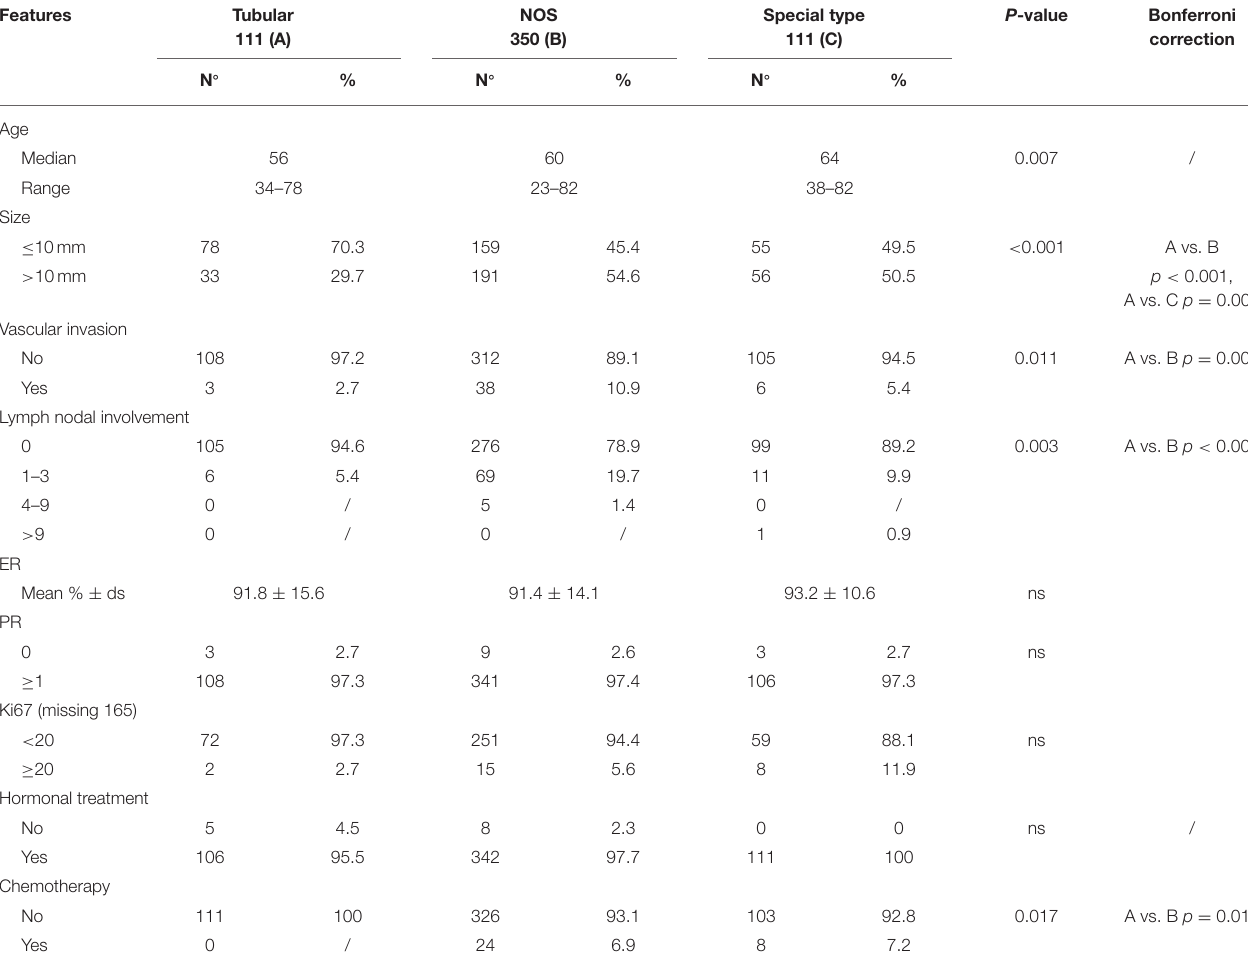
TABLE 1 | Clinical and pathological characteristics and outcome of the whole case series composed by G1 breast cancer patients, stratified according to histotype.